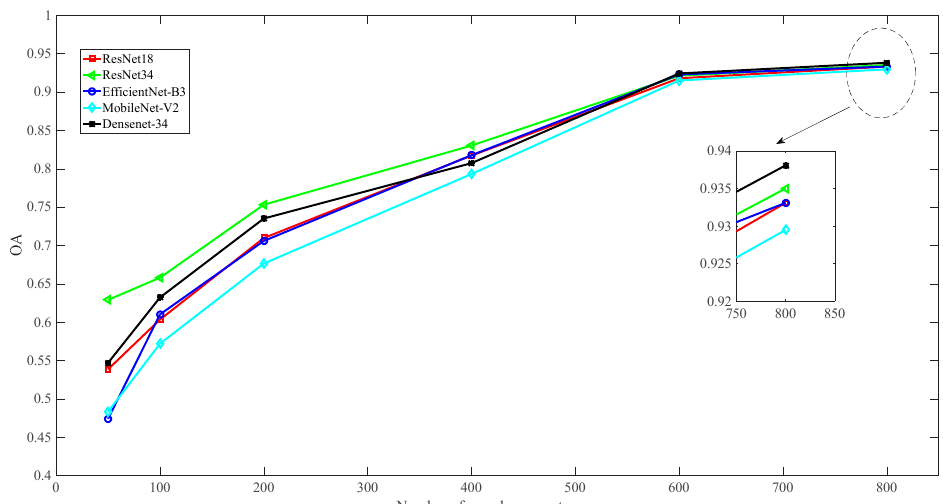
Figure 4. The trend of the overall accuracy of different models with the change of training samples.